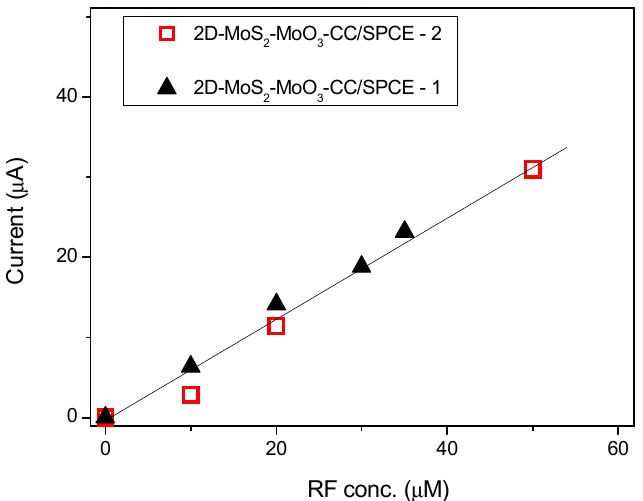
Figure 9. Responses versus riboflavin concentrations with two different 2D-MoS 2 -MoO 3 CC/SPCE sensors. Sensors 2 was fabricated about one year after Sensor 1, using newly prepared 2D-MoS 2 nanosheets.